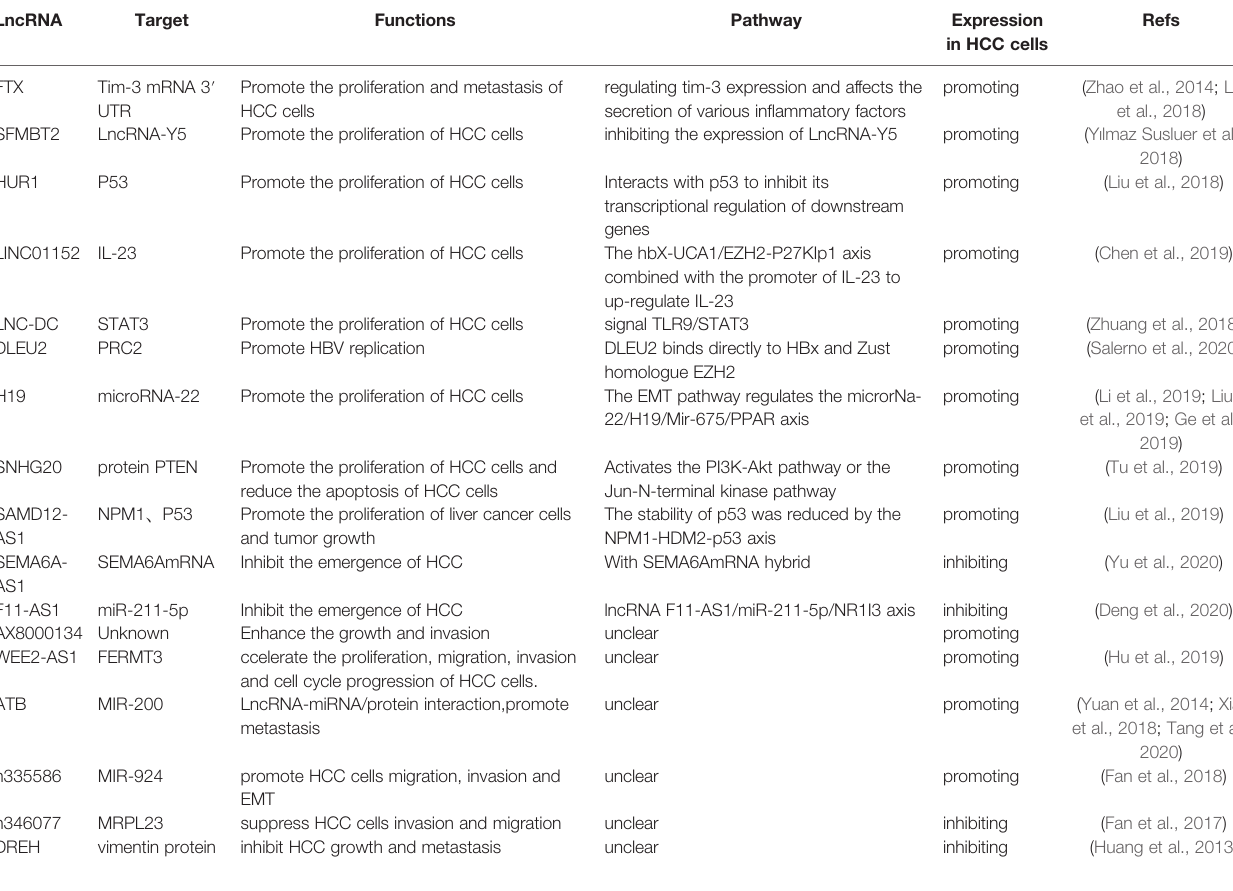
TABLE 1 | lncRNAs linked to HBV related